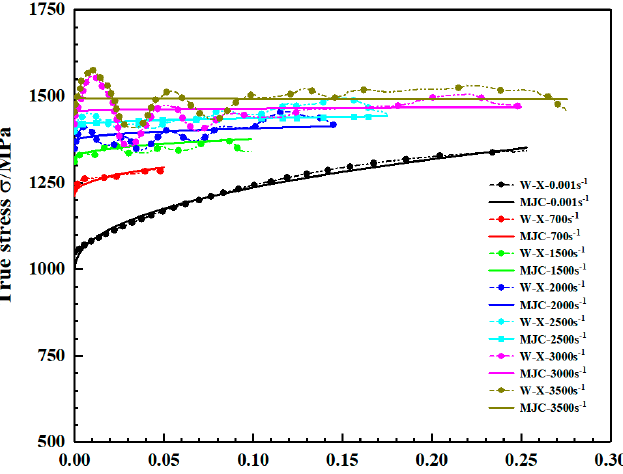
Figure 22. Comparison of flow stresses in the MJ–C model and experiments (scanning direction).